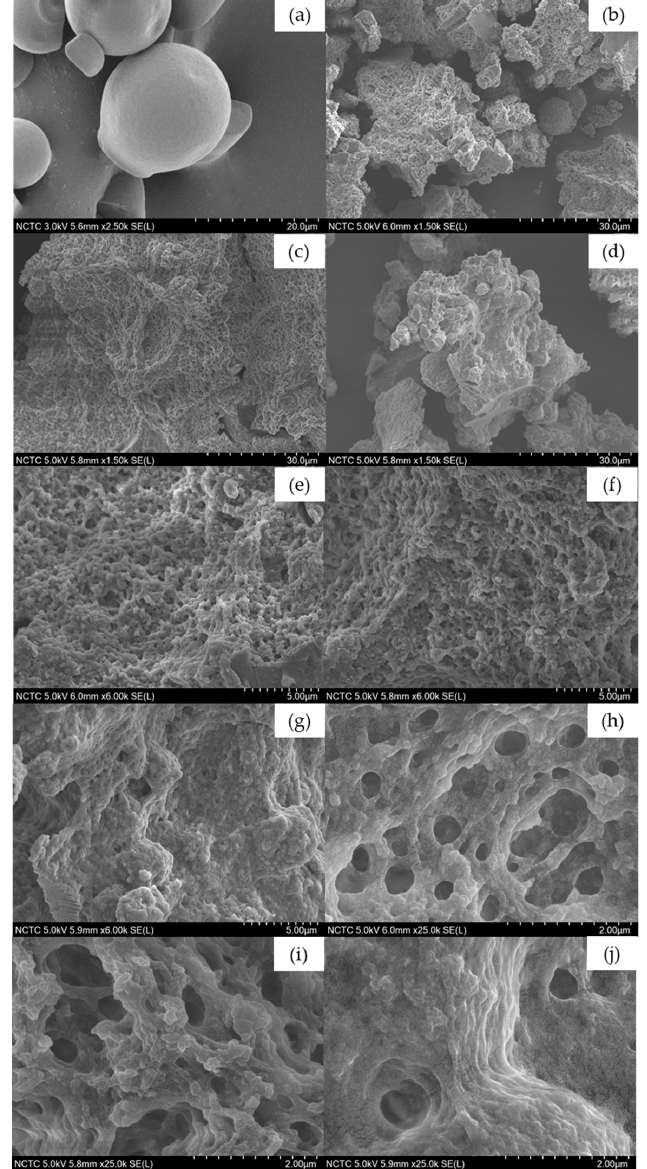
Figure 7. The morphology analysis of HL12Pul-treated modified starch using a Scanning Electron Microscope (SEM). The effect of enzyme loading against a starch structure was observed. ( a ) Untreated cassava starch; ( b – d ): Cassava starch treated with 32, 16, and 8 U/g substrate of HL12Pul, respectively, under 1500 × magnification; ( e – g ): Cassava starch treated with 32, 16, and 8 U/g substrate of HL12Pul, respectively, under 6500 × magnification; ( h – j ): cassava starch treated with 32, 16, and 8 U/g substrate of HL12Pul, respectively, under 25,000 ×